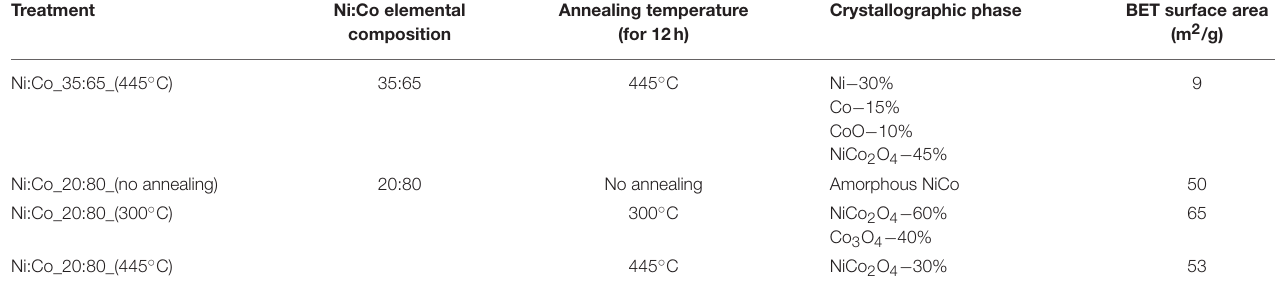
TABLE 1 | Elemental and crystallographic composition, and BET of the synthesized Ni x Co y O z powders. Treatment Ni:Co elemental